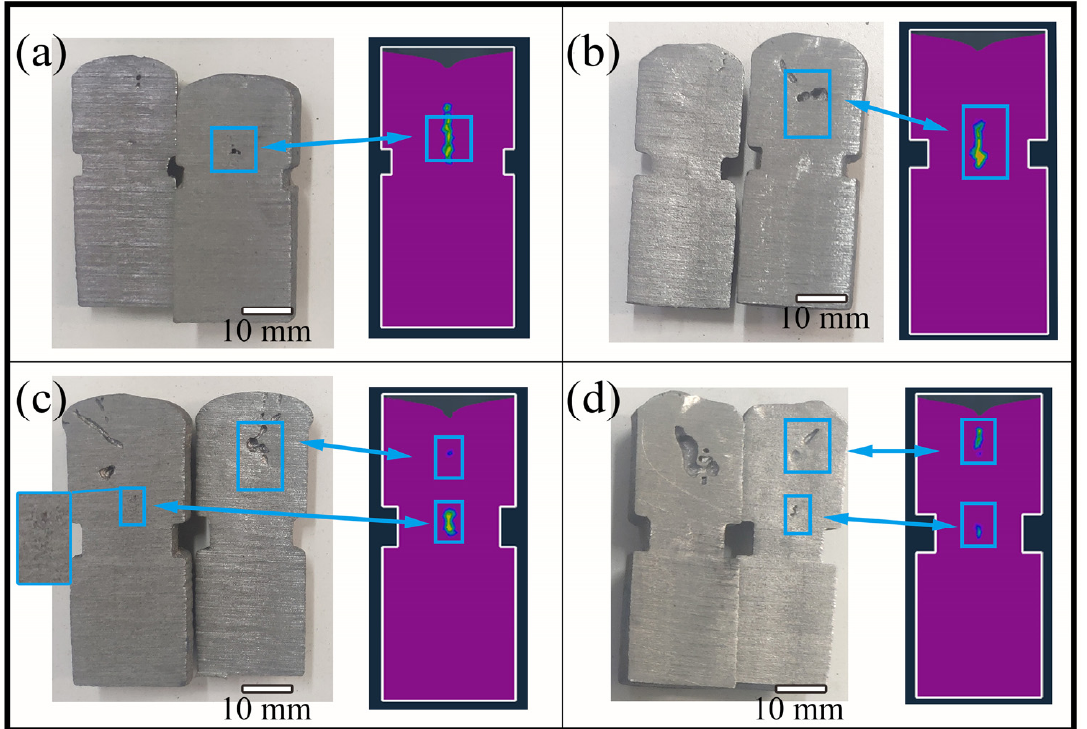
Figure 5. Comparison of experimental and simulation shrinkages of the Ø26 × 55 mm sample with four different neck sizes: ( a ) No. 1 in Table 3, ( b ) No. 2 in Table 3, ( c ) No. 3 in Table 3, and ( d ) No. 4 in Table 3.